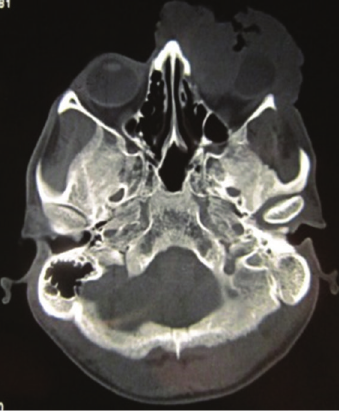
Figure 2: Axial CT scan.